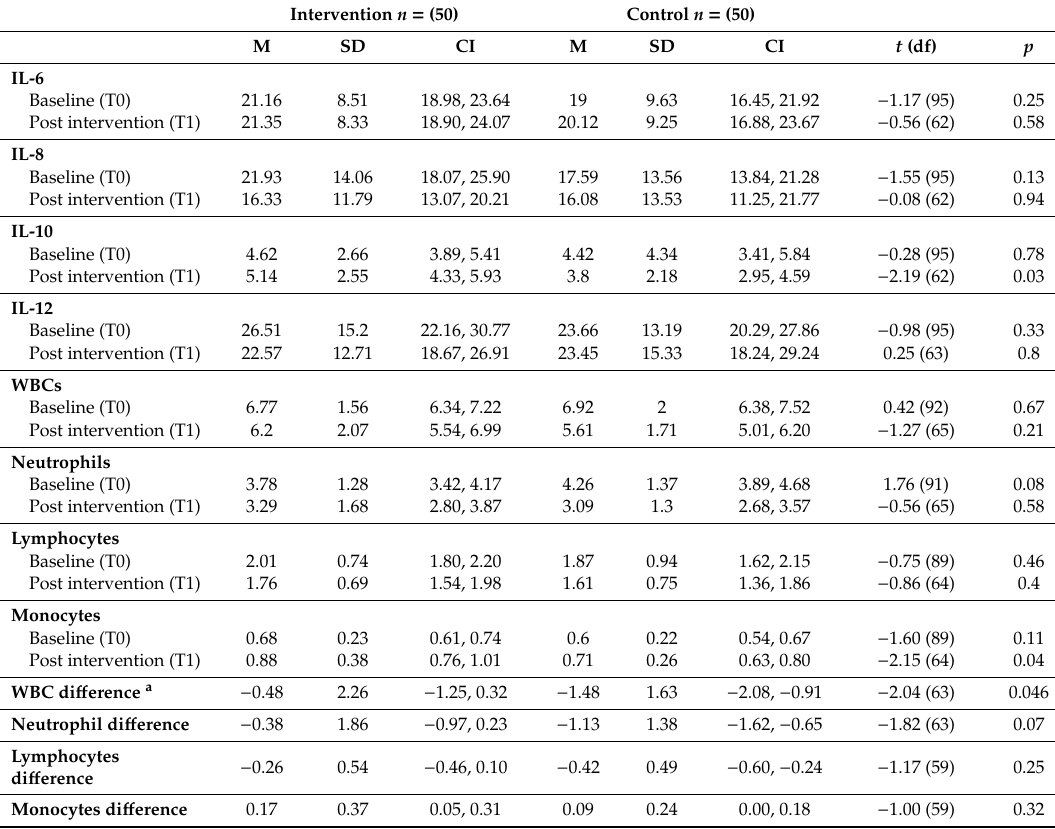
Table 2. Means (SD) of cytokine concentrations a white blood cell (WBC) concentrations b and di ff erences c in WBC concentrations, by group at each assessment